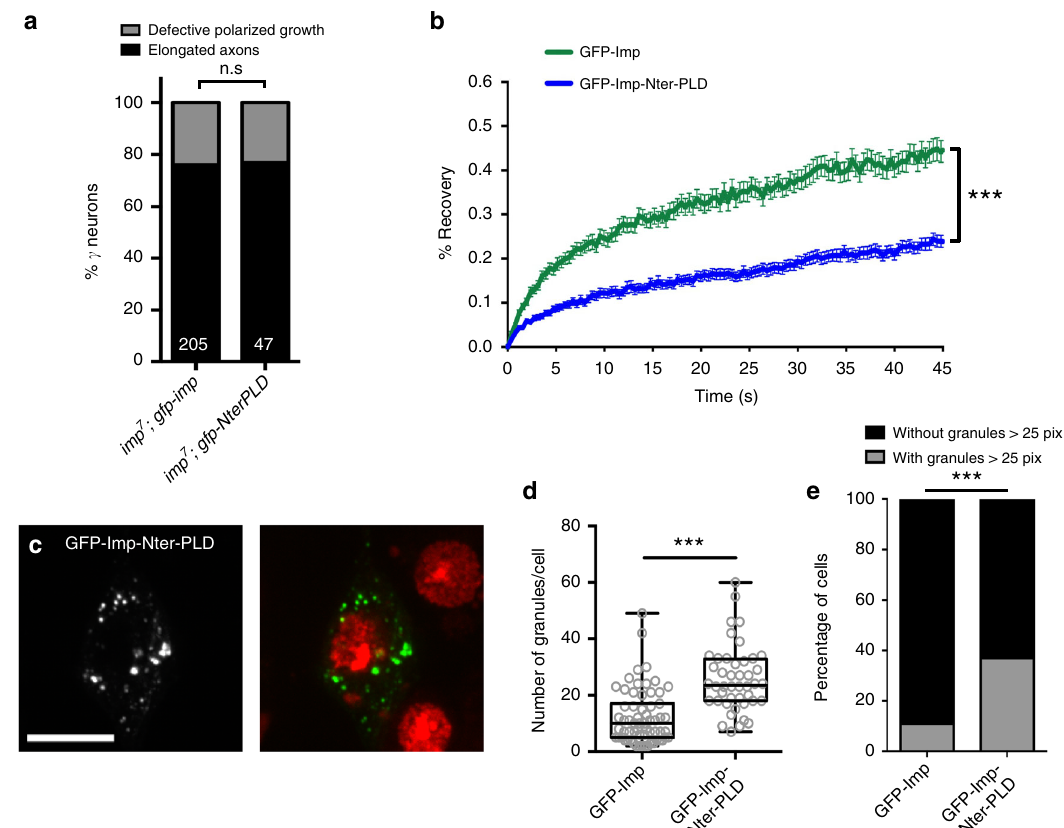
Fig. 9 Imp PLD promotes axon regrowth independently of its role in granule properties. a Percentages of adult γ axons that succeeded (elongated axon) or failed (defective axonal growth) to reach the extremity of the medial lobe in MARCM experiments. n.s. stands for not signi fi cant (Fisher ’ s exact test). Numbers correspond to the total numbers of scored individual axons. Complete genotypes: FRT19A, tub-Gal80, hsp- fl p/FRT19A imp 7 ; 201Y-Gal4, UAS- GFP/UAS- gfp - imp or UAS- gfp - NterPLD . b Average FRAP curves obtained after photobleaching of GFP-positive particles from S2R + cells. The